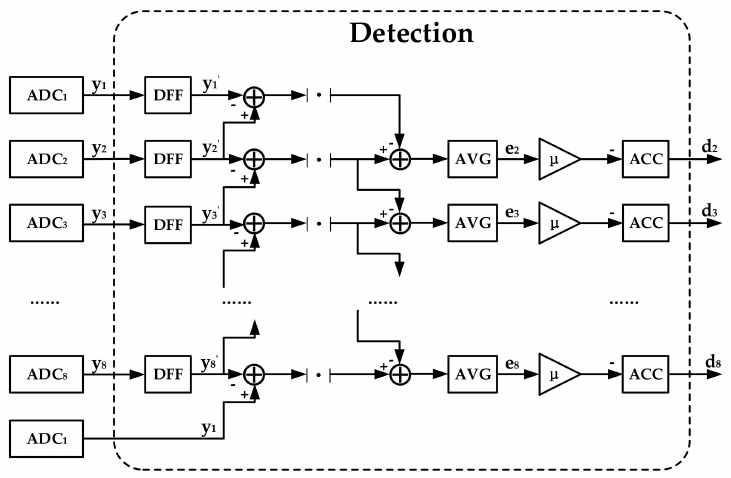
Figure 13. Overall block diagram of wide band timing-mismatch